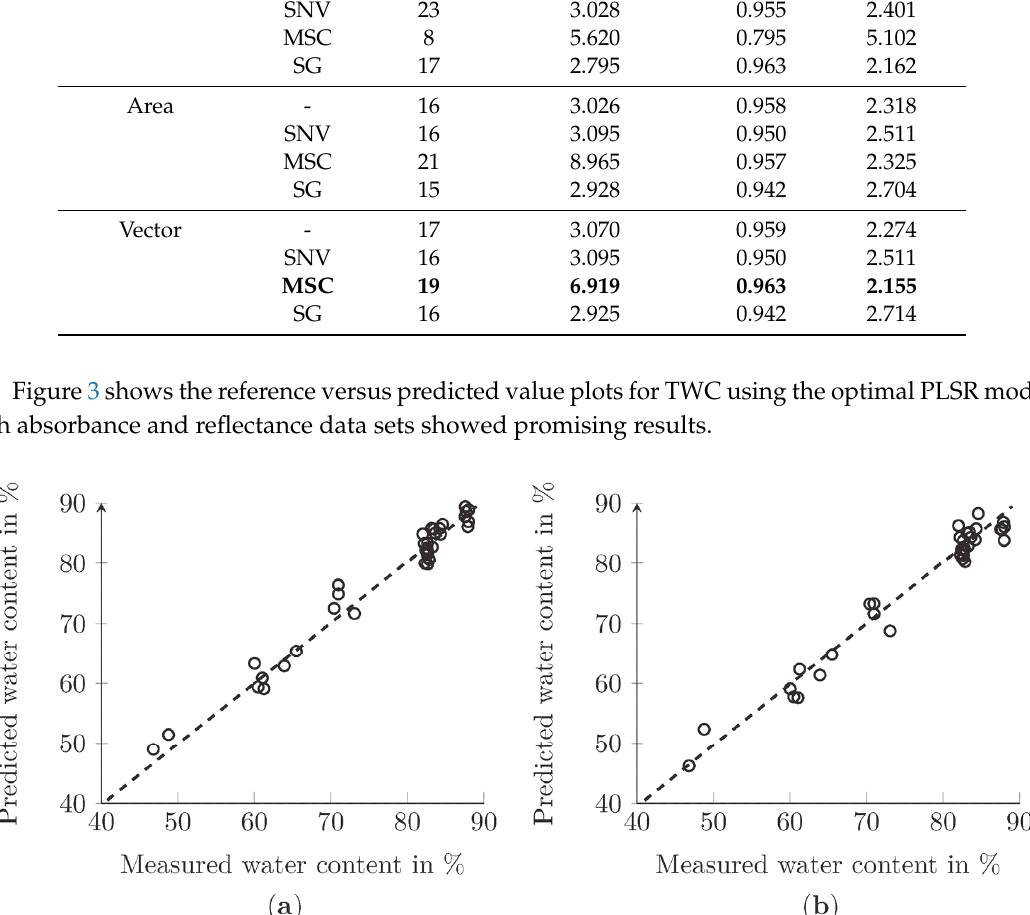
Figure 4. The Bland–Altman plot for ( a ) absorbance and ( b ) reflectance. 3.3. Multivariate Statistical Analysis Based on Optimal Wavelengths The selection of the most influential wavelengths was performed by calculating the β - coefficients derived from the PLSR models. Figure 5 shows the regression coefficients of the best PLSR model, an absorbance model. In general, wavelengths with values close to zero do not contribute to the explanation of the chemical variation. High positive values are positively correlated with the dependent variable water; negative values are negatively correlated. The spectral range between 500 and 700 nm did not allow a definite assignment. A maximum was found at 750 nm. This peak is characterized by the O-H stretching second overtone of water and the spectral properties of deoxyhemoglobin. Due to the overlap of the water peak with the hemoglobin peak [51], the wavelength range of hemoglobin absorption (500–800 nm) is not considered for a future model. The influence of lipid absorption in the 930 nm wavelength range is compensated by a minimum of the regression coefficient. To avoid possible influences on the model by image sensor noise, no wavelengths above 980 nm are used. Since the β -regression coefficient method did not show clear